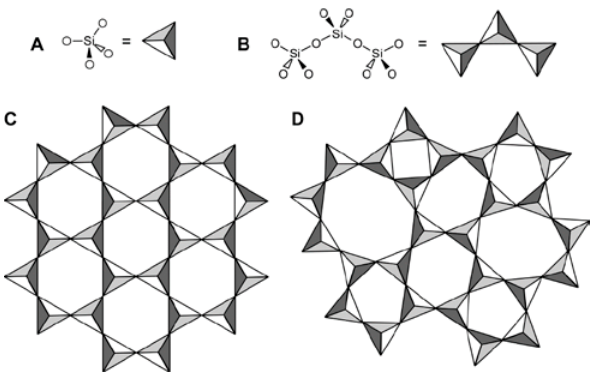
Figure 2. Simplified two-dimensional silicate structures: SiO 4 tet- rahedron (A); oligomeric structure (B); crystalline structure (C); amorphous structure